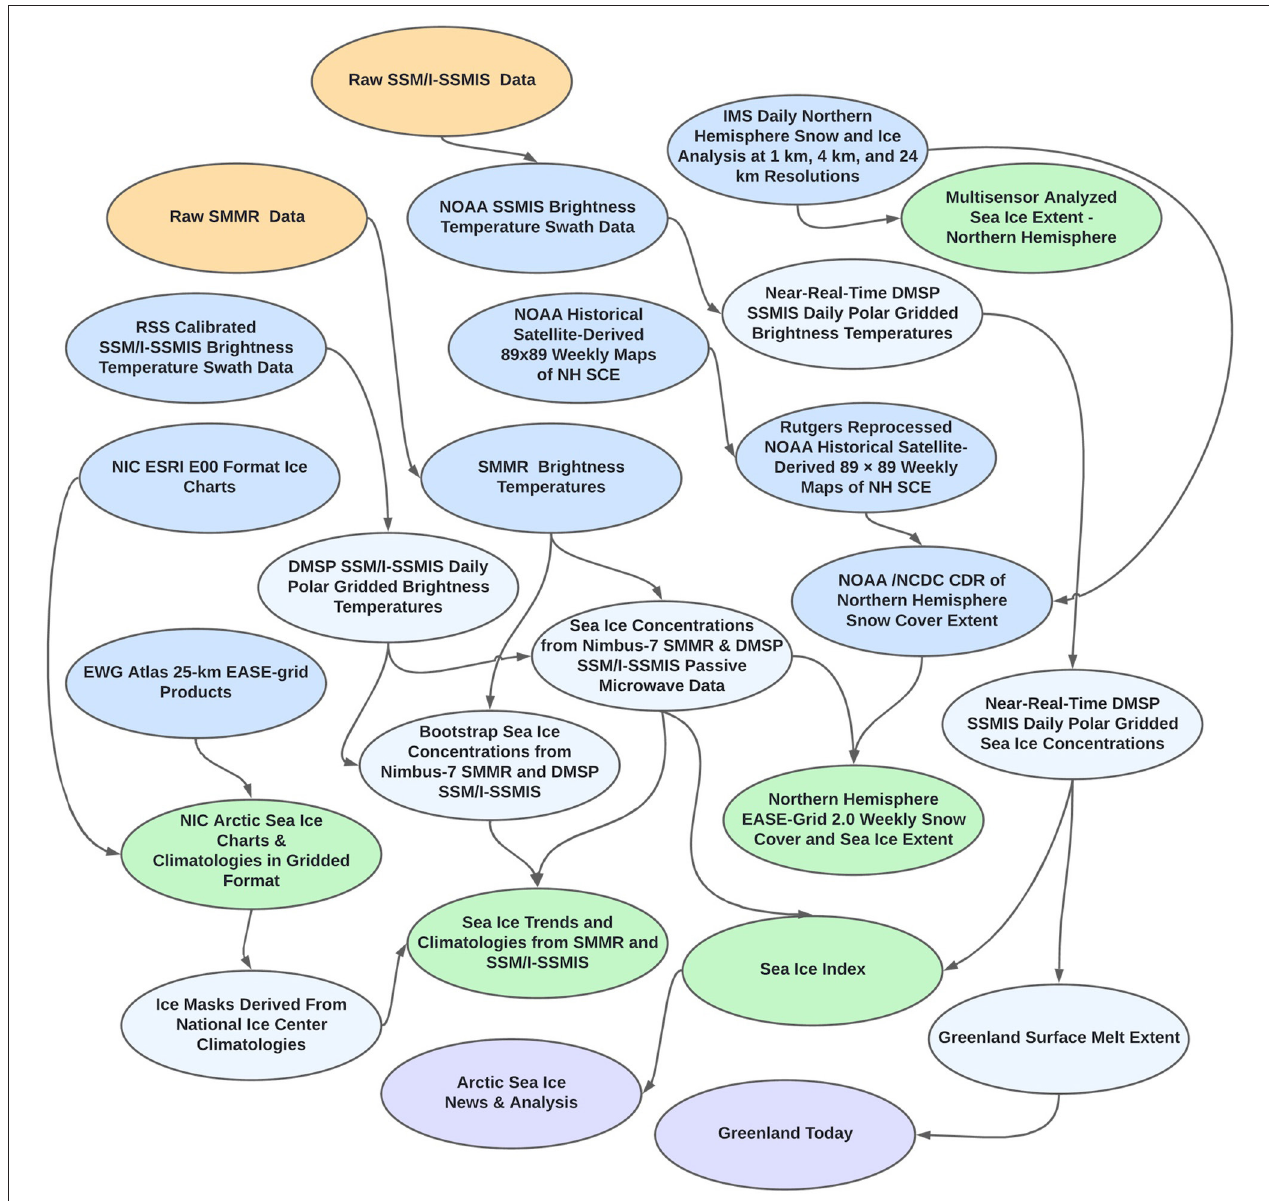
FIGURE 2 | Each bubble represents a data product, most of which are publicly available from NSIDC. Orange products are raw data; while dark blue indicates data external to NSIDC used in creating NSIDC data products. Light blue indicates science products available from NSIDC; while Green indicates products that are NSIDC terms “Easy-to-use”. In NSIDC’s view these data products are in “formats that require little or no processing or programming. These may be of particular interest to K-12 teachers and students, the press, the general public, or non-cryospheric researchers.” (NSIDC, 2022). Purple represents science products (blogs) also available from the NSIDC homepage that provide data interpretation for broad audiences. Figure adapted and updated from Baker et al.